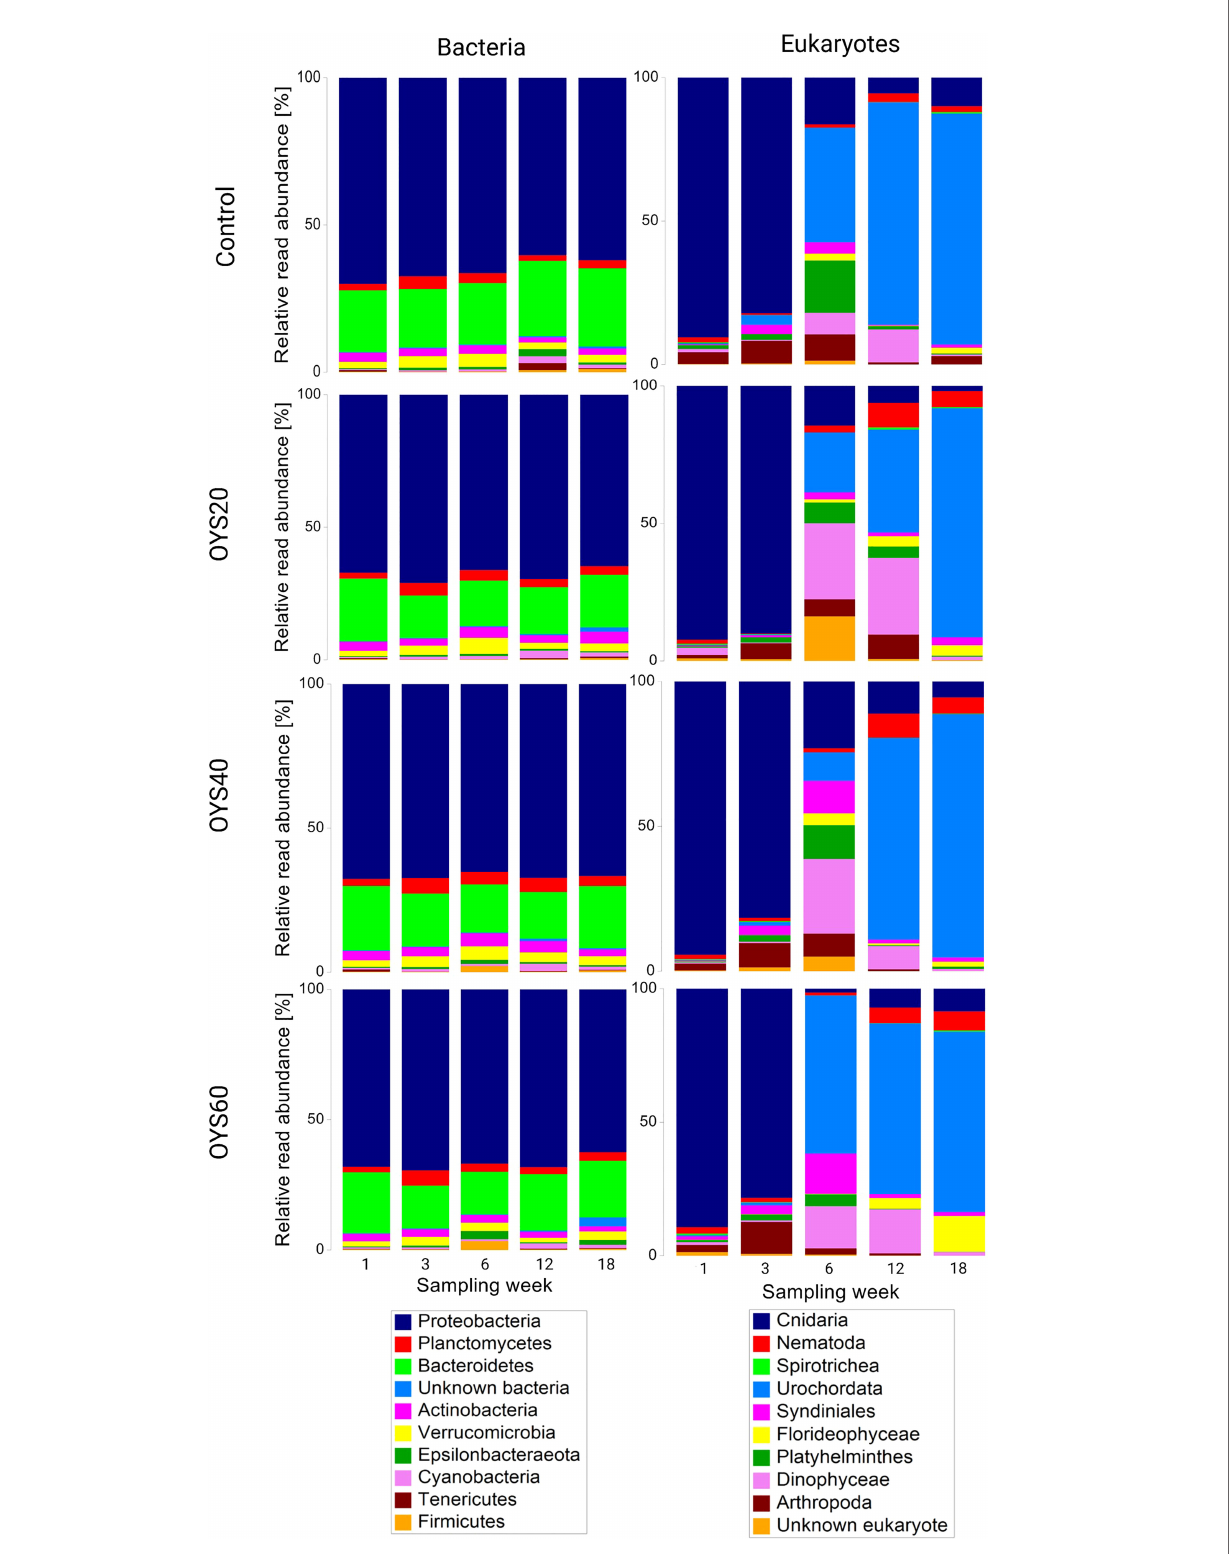
FIGURE 4 | Relative read abundance of the ten most dominant bacterial phyla (left) and eukaryotic classes (right) among the different treatments (Sampling times and Polymer type).